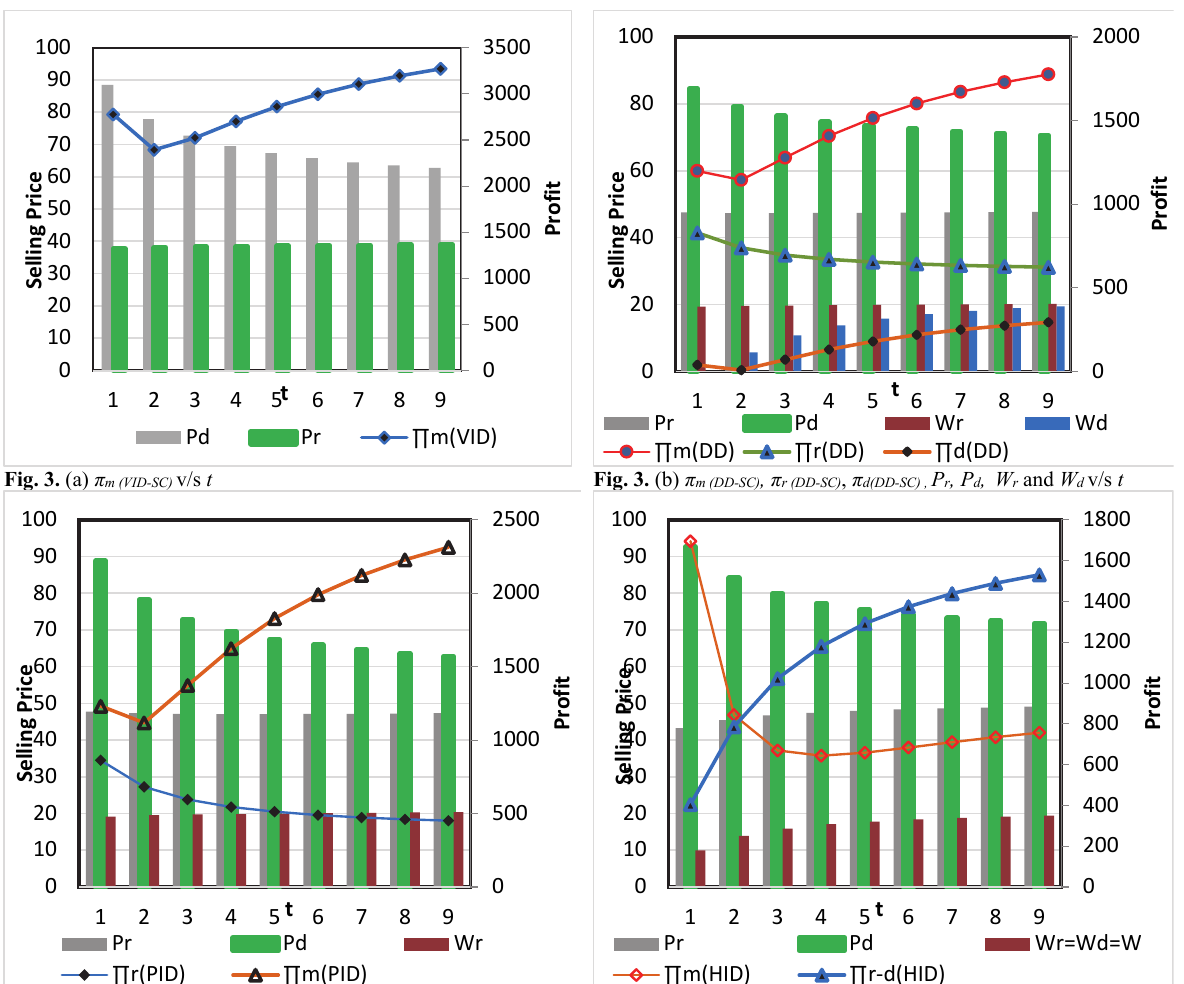
Fig. 3. (c) π r (PID-SC) , π m (PID-SC) , P r , P d and W r v/s t Fig. 3. (d) π r (HID-SC) , π m (HID-SC) , P r , , P d and W r v/s